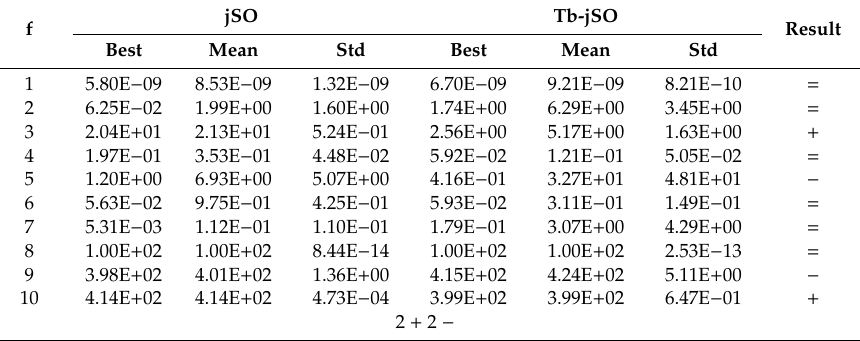
Table 18. jSO vs. Tb-jSO on CEC2020 in 20 D .